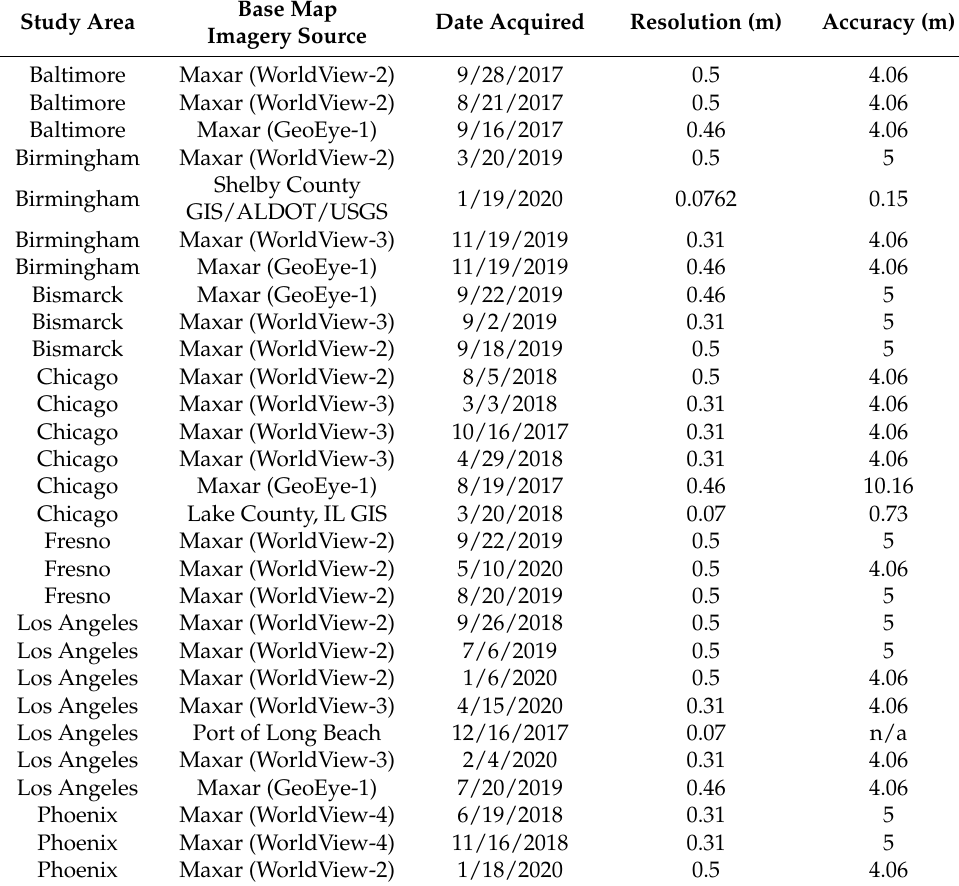
Table A1. Sources of the ArcMap base map imagery overlapping control points in each study area used for the geolocation comparison (Sections 2.5 and